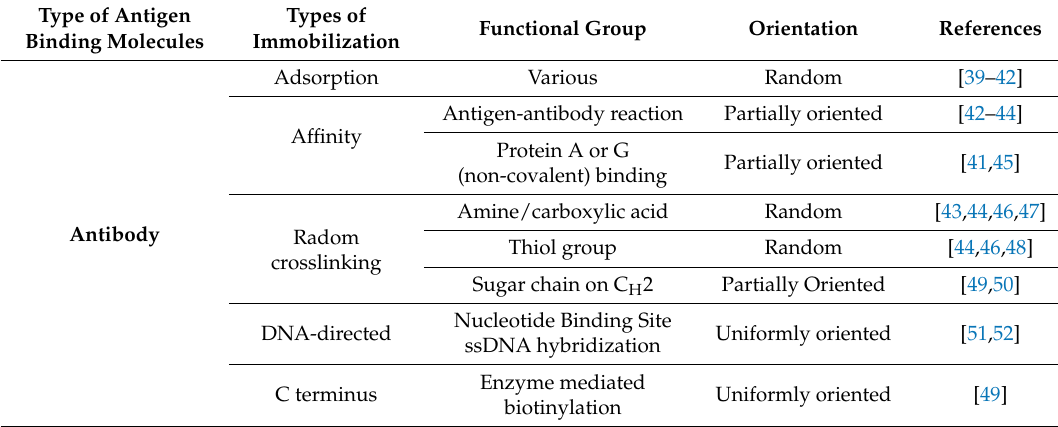
Table 2. A summary of popular conjugation